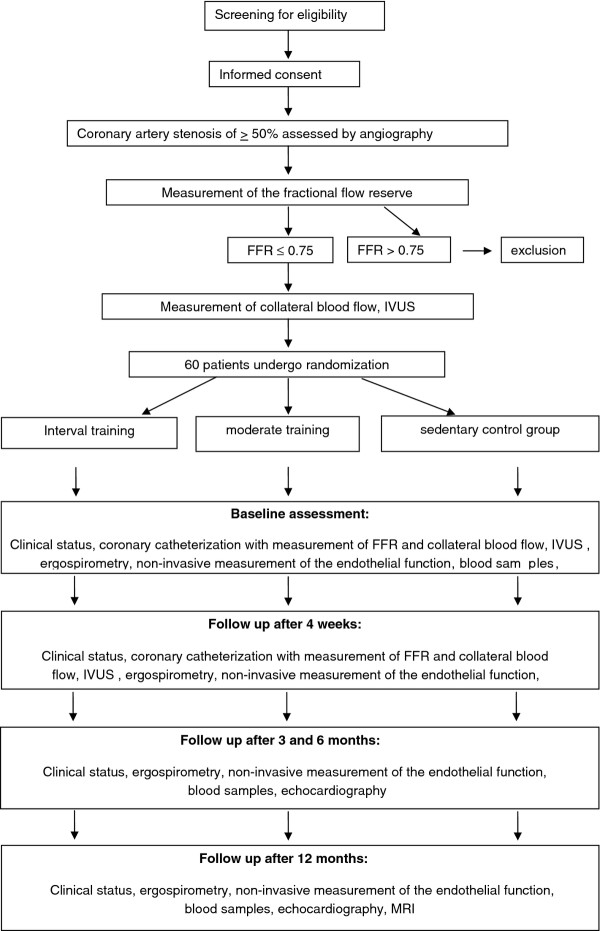
Study flow chart.